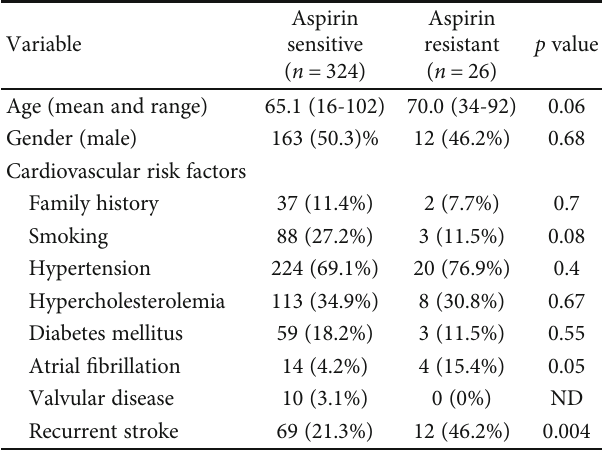
Table 2: Comparison of stroke patients with and without aspirin